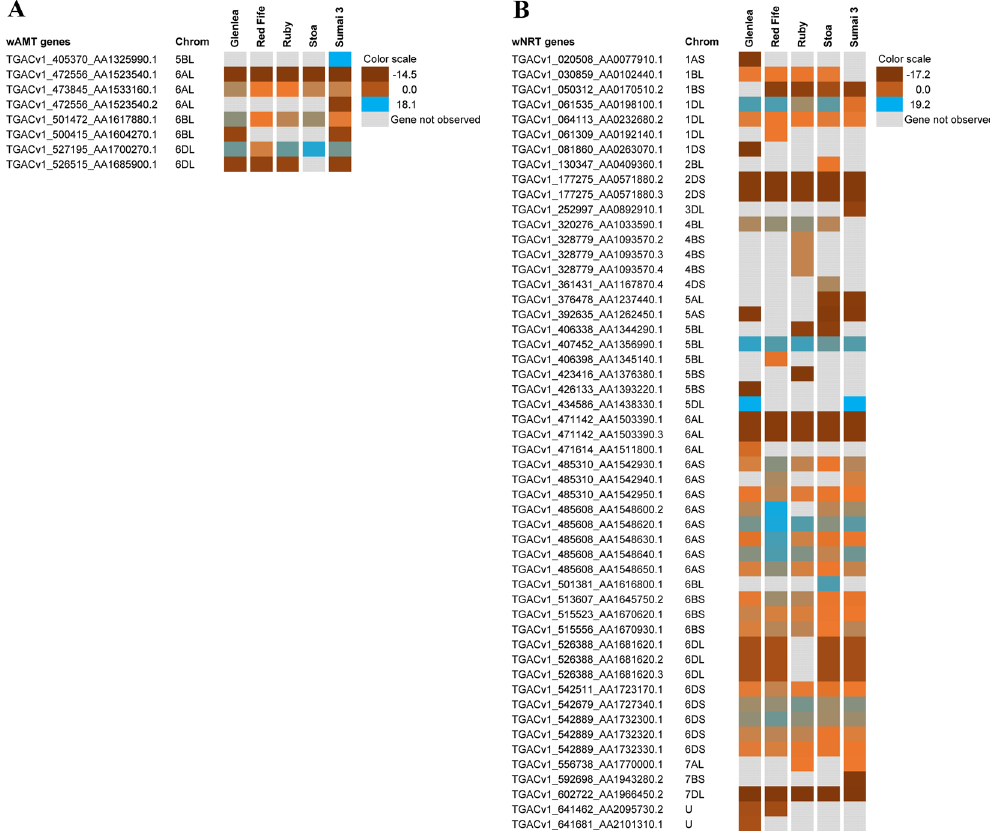
Figure 1. Heatmaps showing intensity (log fold change) of differentially expressed wheat ammonium (wAMT) genes ( A ) and nitrate (wNRT) transporter genes ( B ) in five spring wheat lines. Eight wAMT genes and 52 wNRT genes were found to be differentially expressed between root and shoot of the five lines. Chromosome labeled ‘U’ indicates that the scaffold housing the gene has not been assigned to a